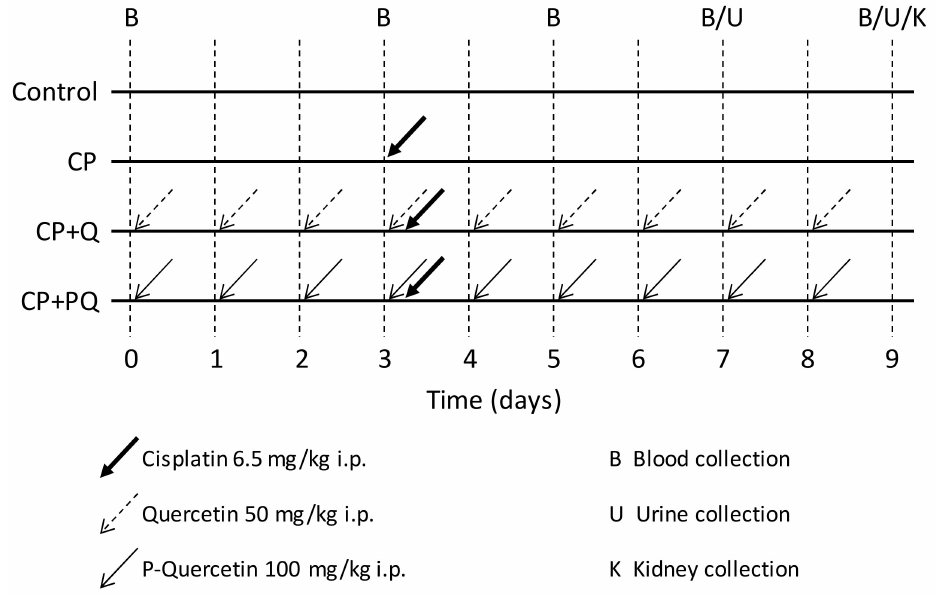
Figure 6. Scheme of the nephrotoxicity model. CP: cisplatin (6.5 mg/kg, i.p.) on day 3; CP + Q: quercetin (50 mg/kg, i.p.) for 9 days and cisplatin (6.5 mg/kg, i.p.) on day 3; CP + PQ: P-quercetin (100 mg/kg, i.p.) for 9 days and cisplatin (6.5 mg/kg, i.p.) on day